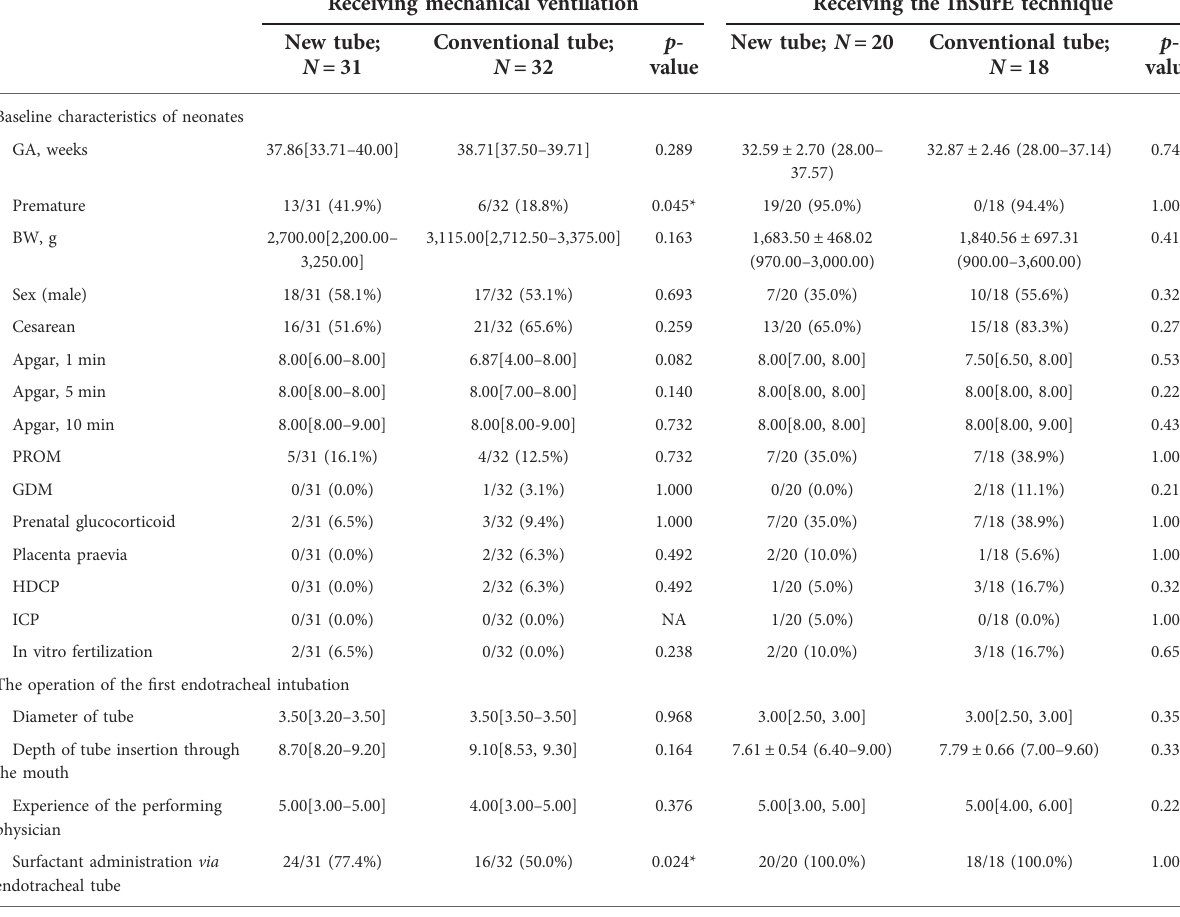
TABLE 3 Basic information on newborns receiving invasive mechanical ventilation and the InSurE